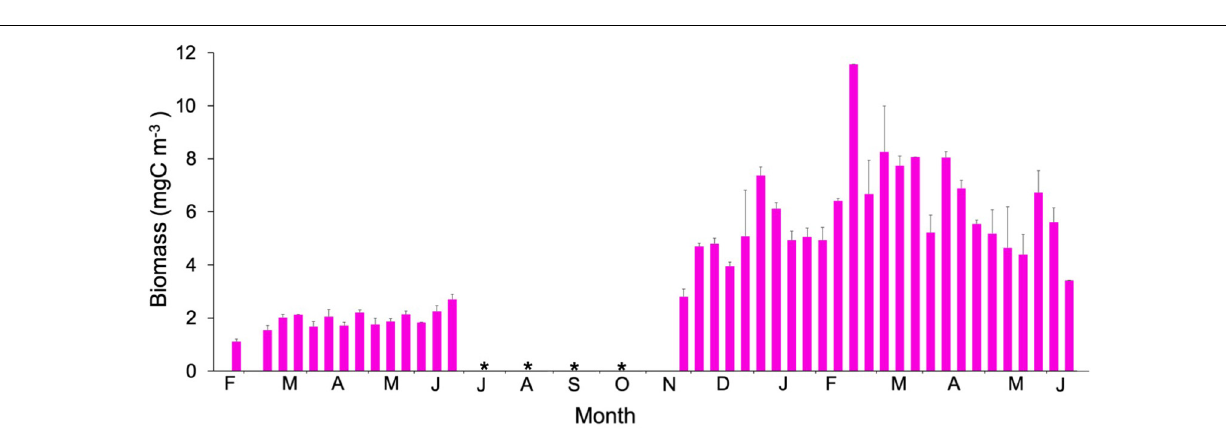
Saharan dust also contains silicates (Goudie and Middleton, 2001; Viana et al., 2002) although its concentration in the ocean remained slightly lower in 2010 (0.52 µ M ± 0.13 SD) than in 2011 (0.66 µ M ± 0.3 SD) but not significantly different. It was